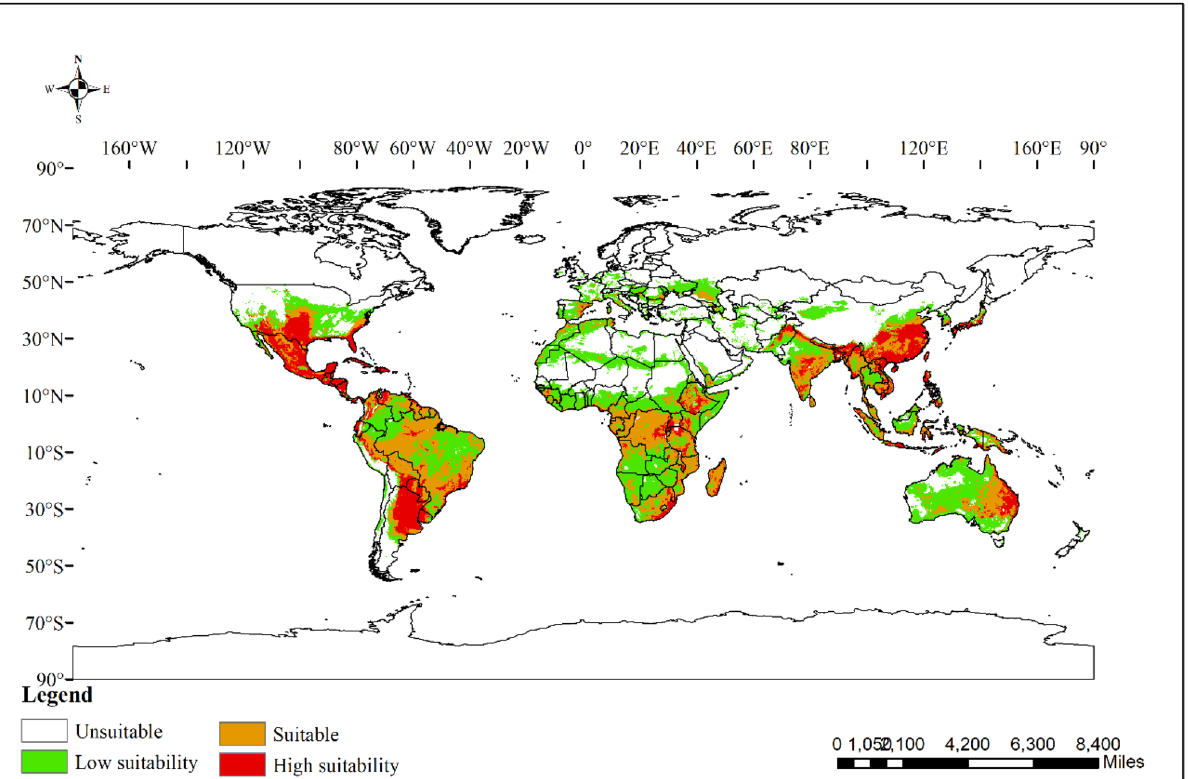
Figure 1. Map of suitable habitat areas for Sapindus under current climate conditions. Created in ESRI ArcMap 10.5 (https:// suppo rt. esri. com/ en/ Produ cts/ Deskt op/ arcgis- deskt op/ arcmap). Suitable